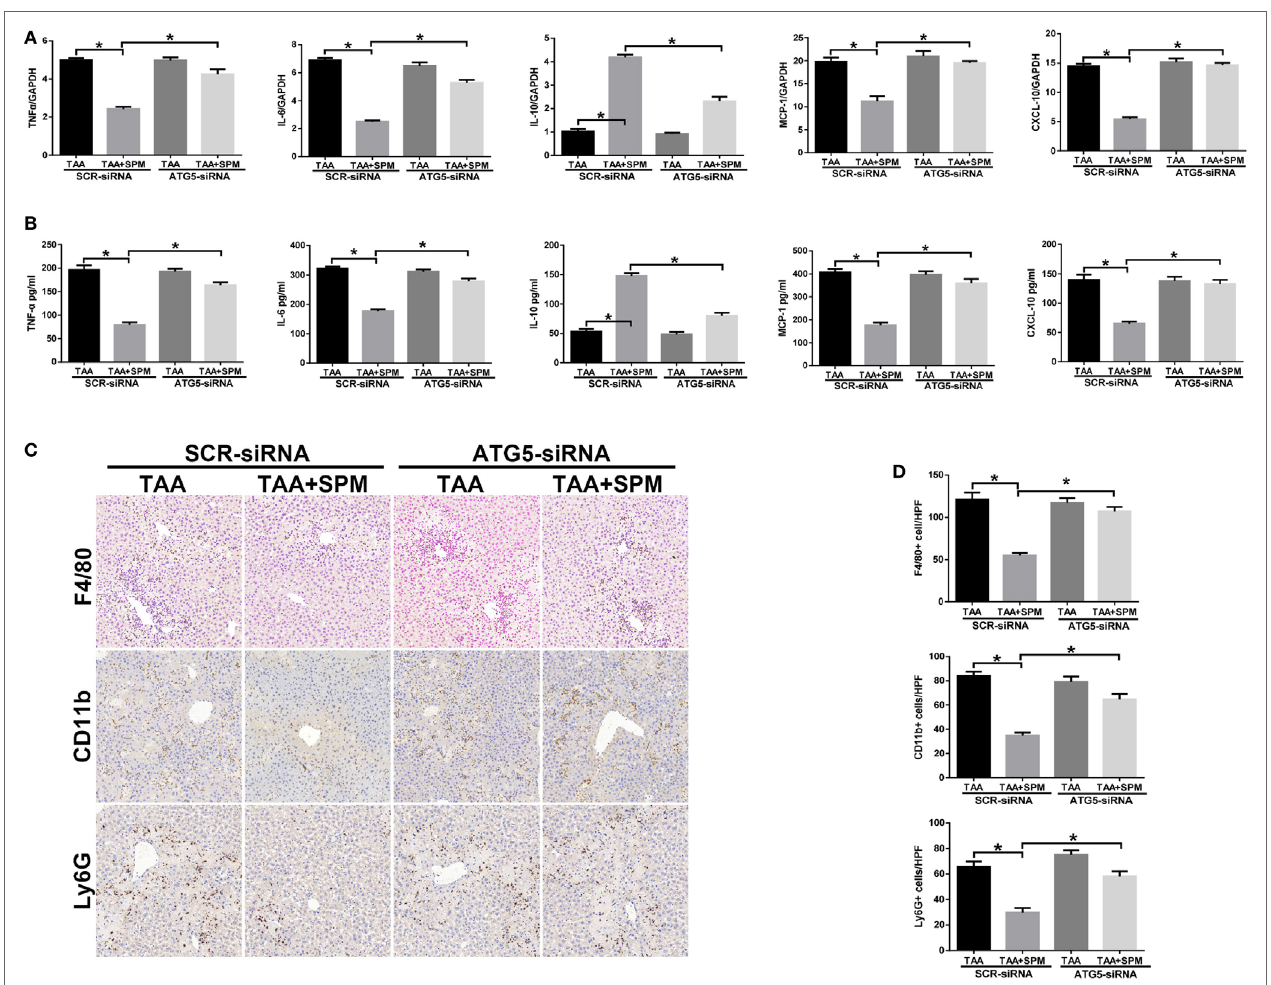
FigUre 7 | Spermine (SPM)-mediated KC autophagy inhibits inflammatory immune activation. Mice were subjected to SPM pretreatment and thioacetamide (TAA) administration as described in Section “Materials and Methods.” Both TAA and TAA + SPM mice were pretreated with ATG5 siRNA (ATG5-siRNA) or its scrambled control siRNA (SCR-siRNA) in vivo prior to TAA administration using mannose-conjugated polymers as described in Section “Materials and Methods.” Inflammatory gene expression in liver tissue was evaluated by quantitative RT-PCR [ (a) , n = 6/group]. Serum levels of inflammatory cytokines were measured by ELISA [ (B) , n = 6/group]. F4/80 + macrophages, CD11b + macrophages, and Ly6G + neutrophils infiltration in liver was detected by immunohistochemical staining [ (c) , n = 6/ group]. Quantification of F4/80 + macrophages, CD11b + macrophages, and Ly6G + neutrophils per high power field (original magnification 20 × ). Representative of six mice/group (D) (* p <